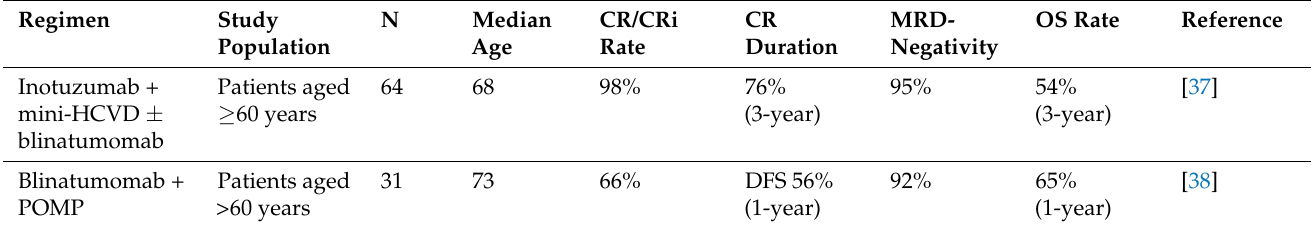
Table 4. Combination trials for first-line Ph-negative ALL (older